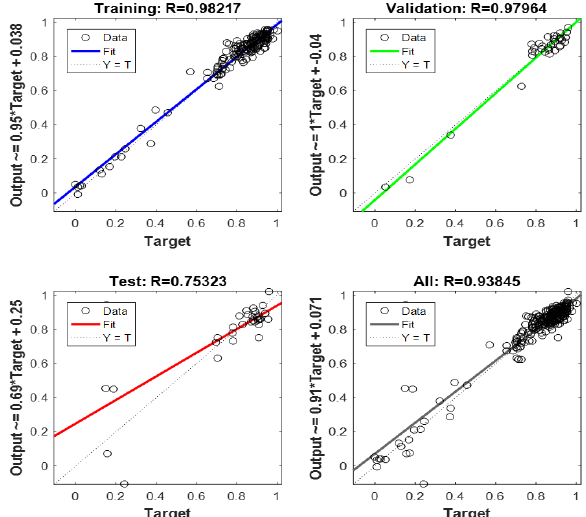
Figure 17. Correlation analysis graph(* represents the multiplication).